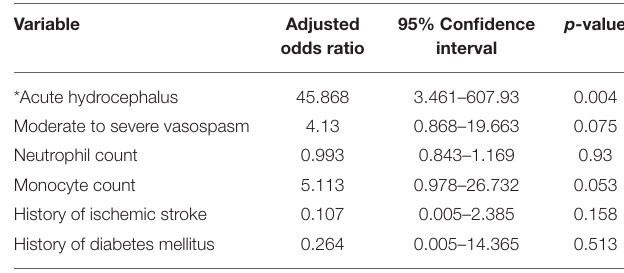
TABLE 3 | Multivariate logistic regression analysis with adjusted odds ratios of shunt dependence after aneurysmal subarachnoid hemorrhage (acute hydrocephalus variable excluded).